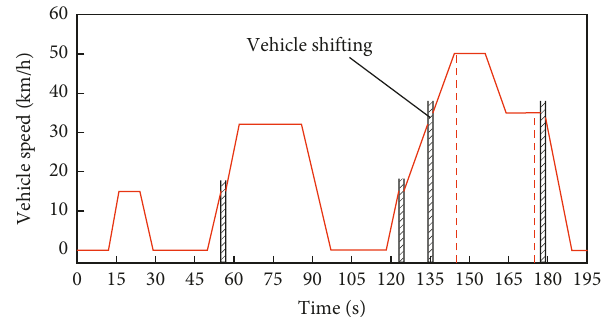
Figure 19: The schematic diagram of the urban conditions